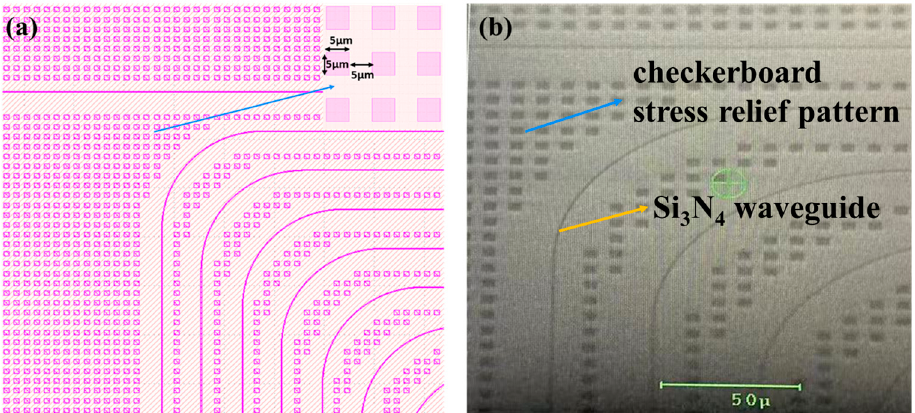
Figure 8. ( a ) Layout design of the checkerboard stress relief pattern; ( b ) SEM images of the checker- board stress relief pattern.